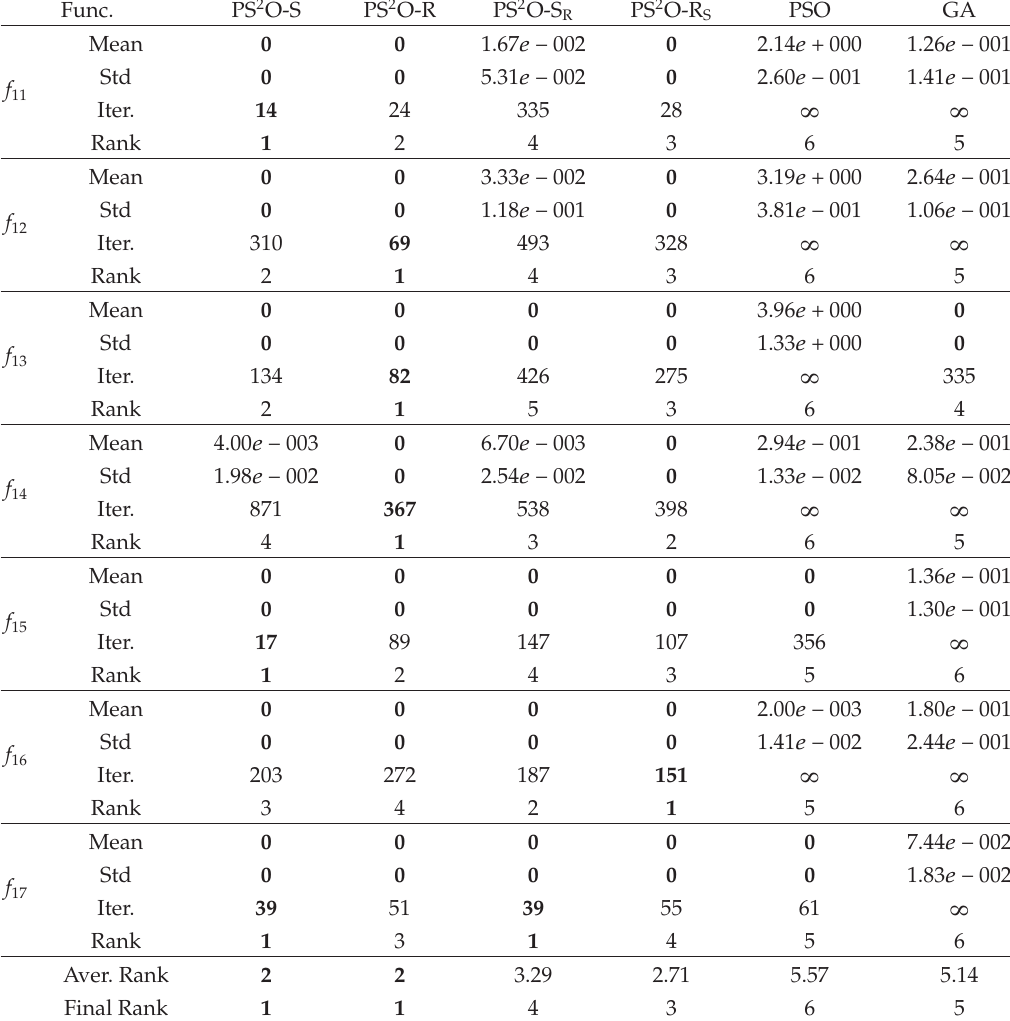
Table 5: Performance of all algorithms on benchmark functions f 11 – f 17 . In bold are the best results.